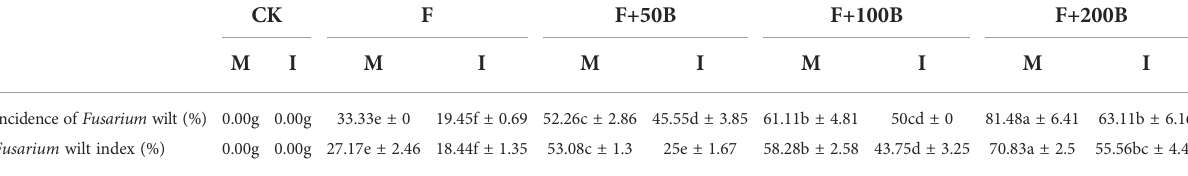
TABLE 1 Effects of different concentrations of benzoic acid on incidence and disease index of faba bean ( Vicia faba ) Fusarium wilt under different cropping modes. CK F